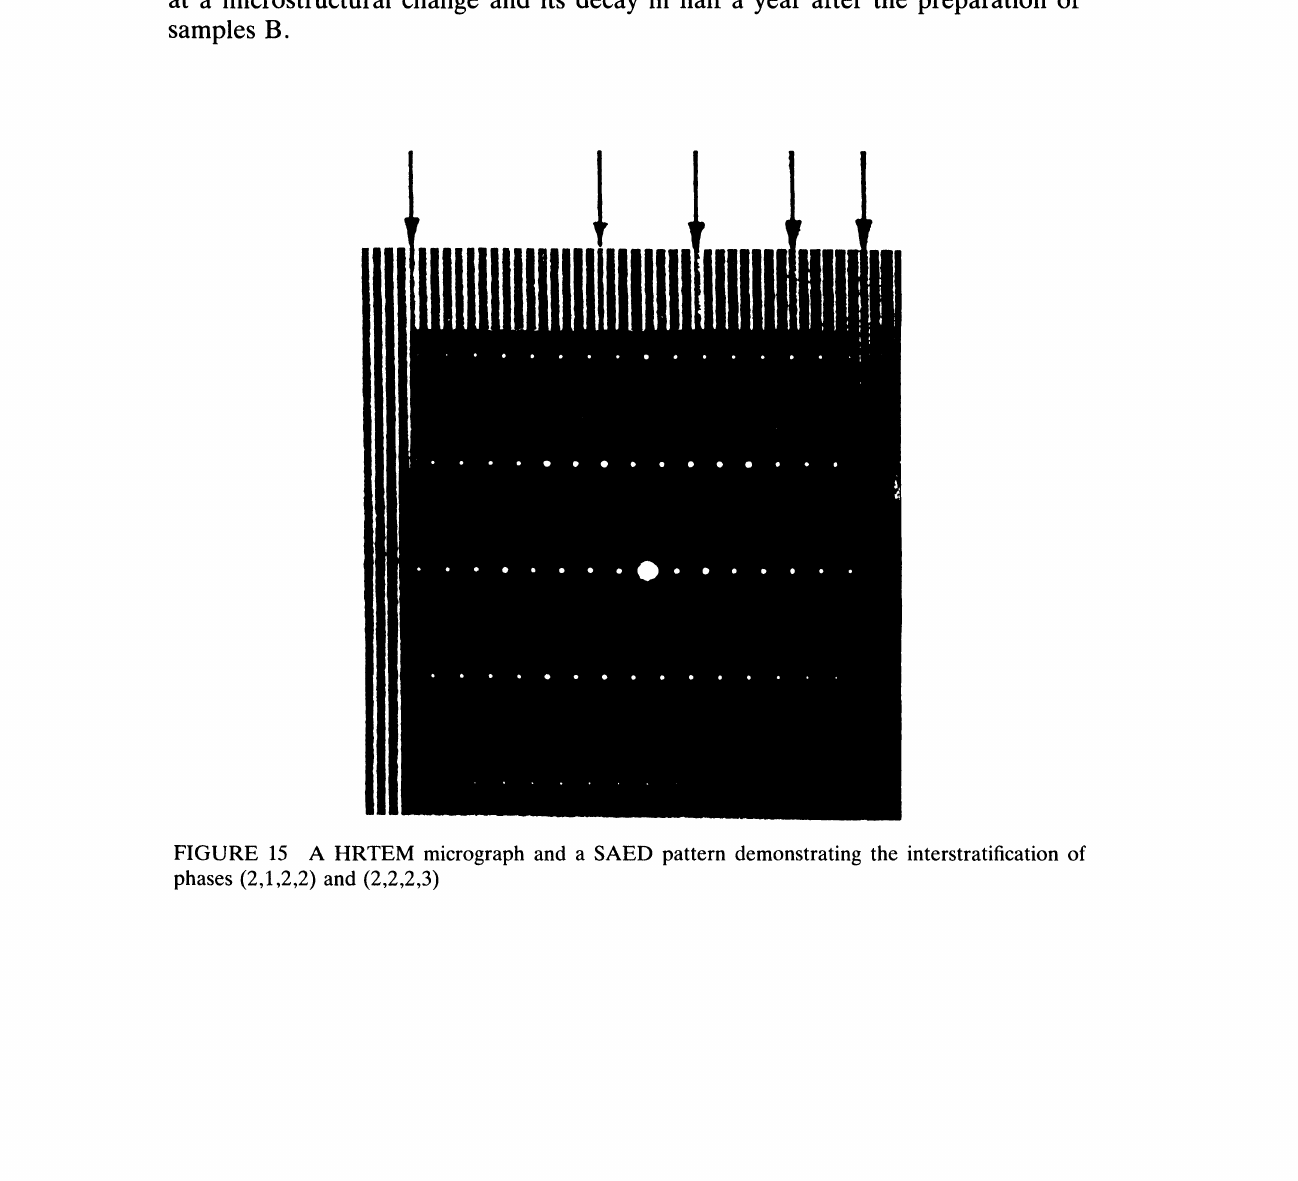
FIGURE 15 A HRTEM micrograph and a SAED pattern demonstrating the interstratification of phases (2,1,2,2) and